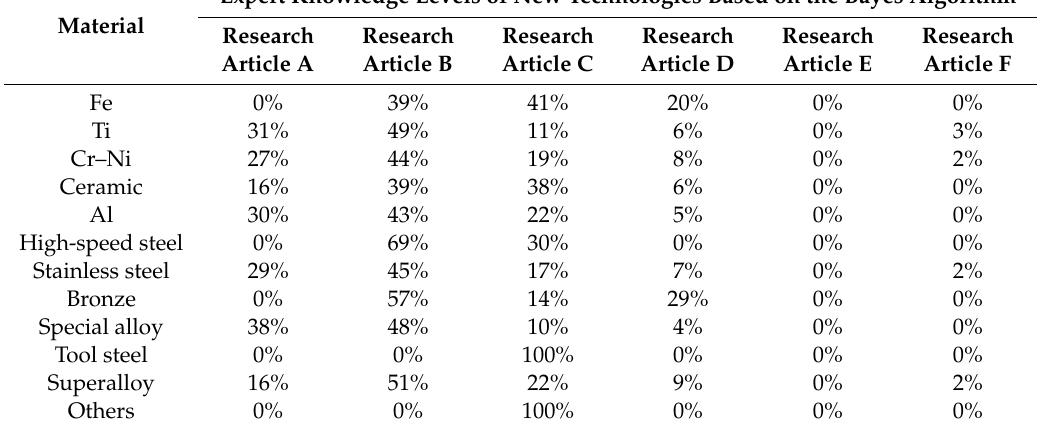
Table 2. Knowledge levels of new technologies based on the Bayes algorithm (factor: material). Expert Knowledge Levels of New Technologies Based on the Bayes Material